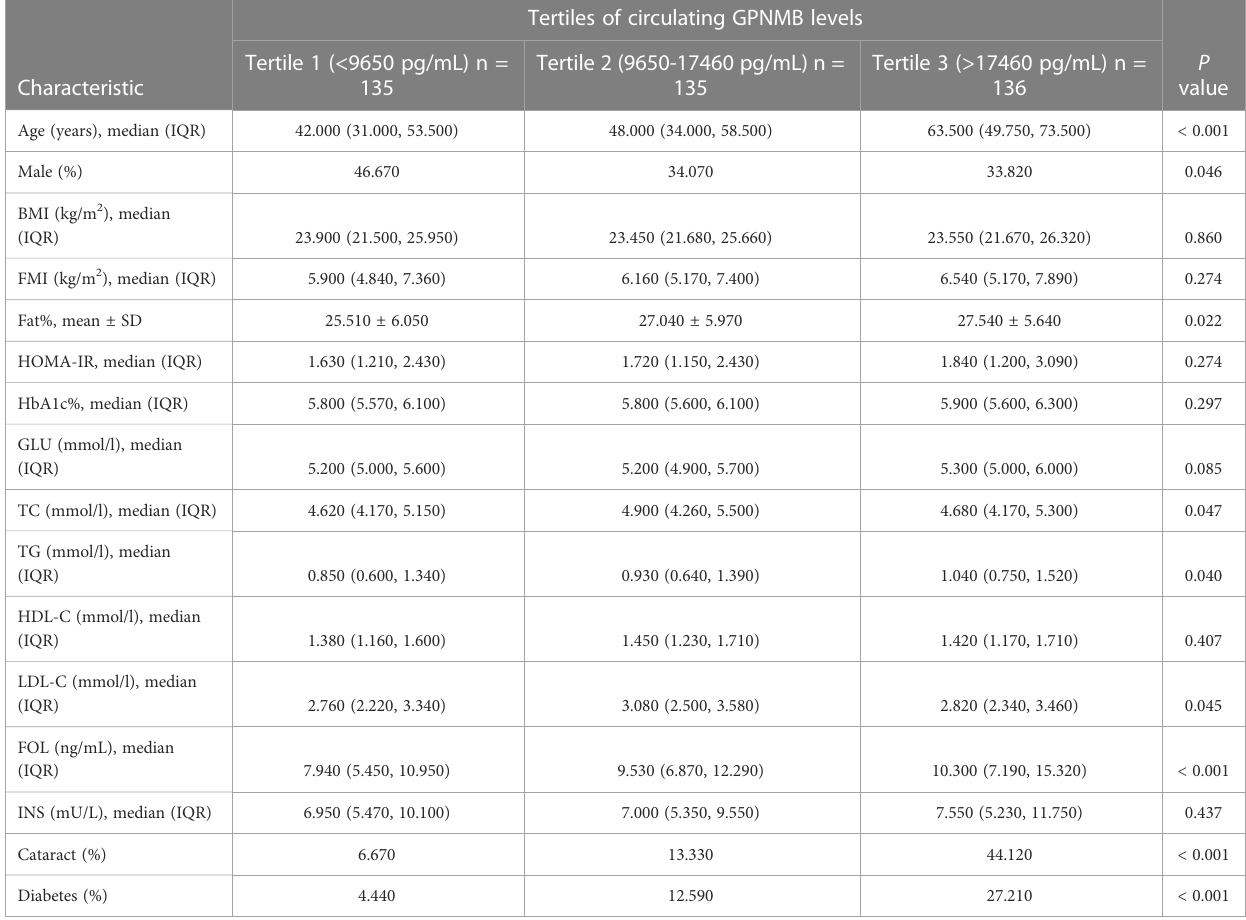
TABLE 4 General characteristics of patients by tertiles of plasma GPNMB level.